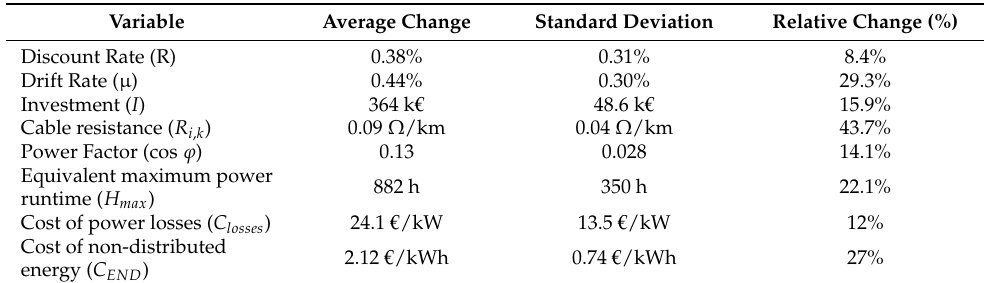
Table 5. Average value increments inducing a change of 1 MW in the optimal